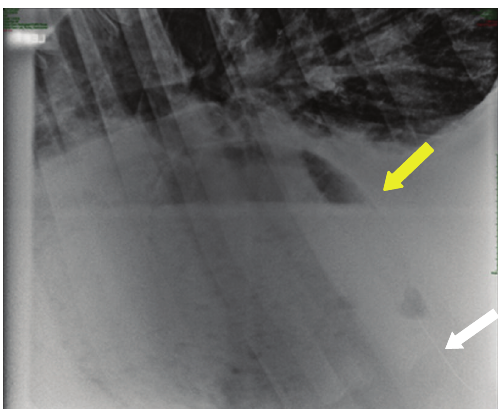
Figure 1: Laterolateral radiograph showing circumscribed mass with a fluid line and an area of gas shadows dorsally superimposing in the cardiac region (yellow arrow), thin opaque foreign material in the region of the caudal thorax (white arrow).